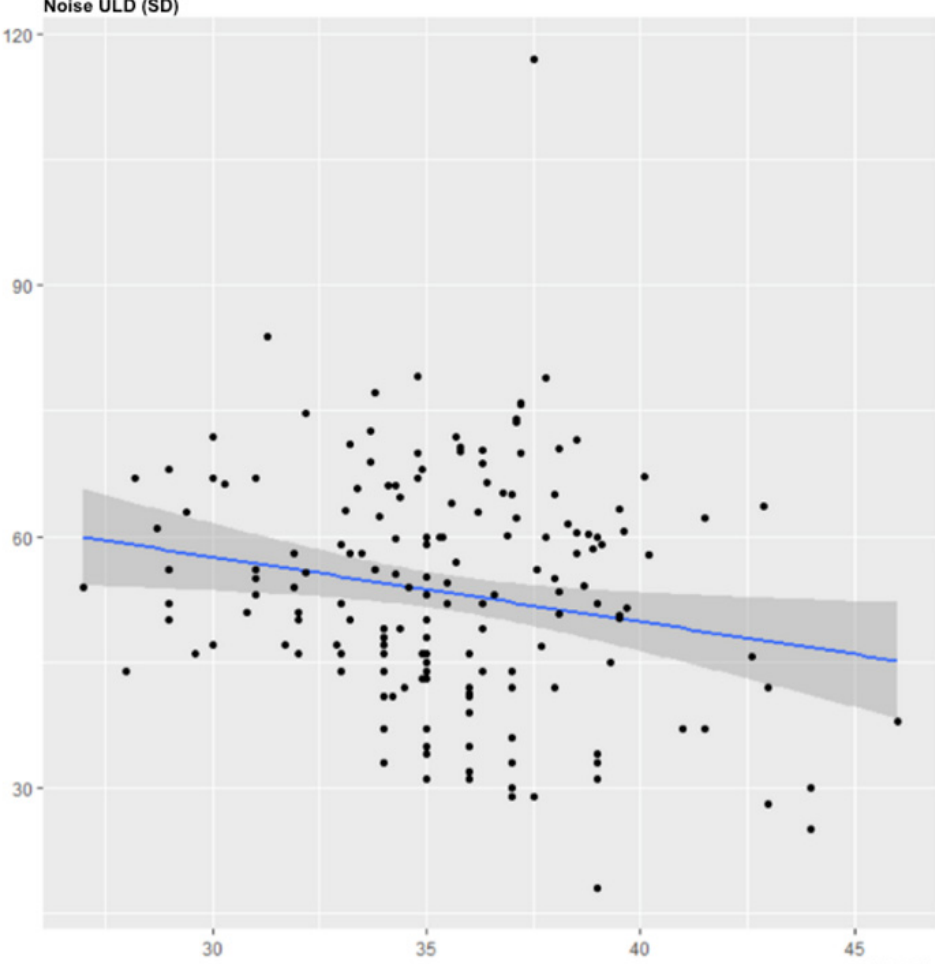
Figure 2. Influence of MTCD on image noise (in SD) for ULD-CT.